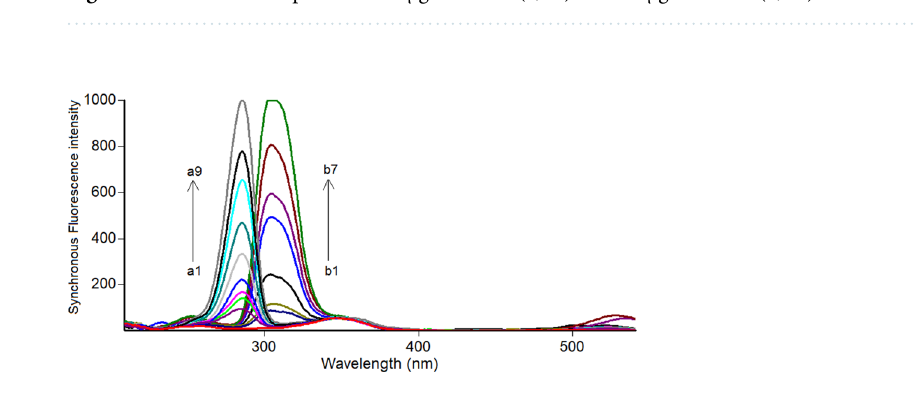
Figure 4. Synchronous fluorescence spectra of increasing concentrations of PHL (a1-a9: 0.05–6.0 μg/mL) and EPH (b1-b7: 0.02–1.0 μg/mL) in methanol at Δλ of 40 nm.